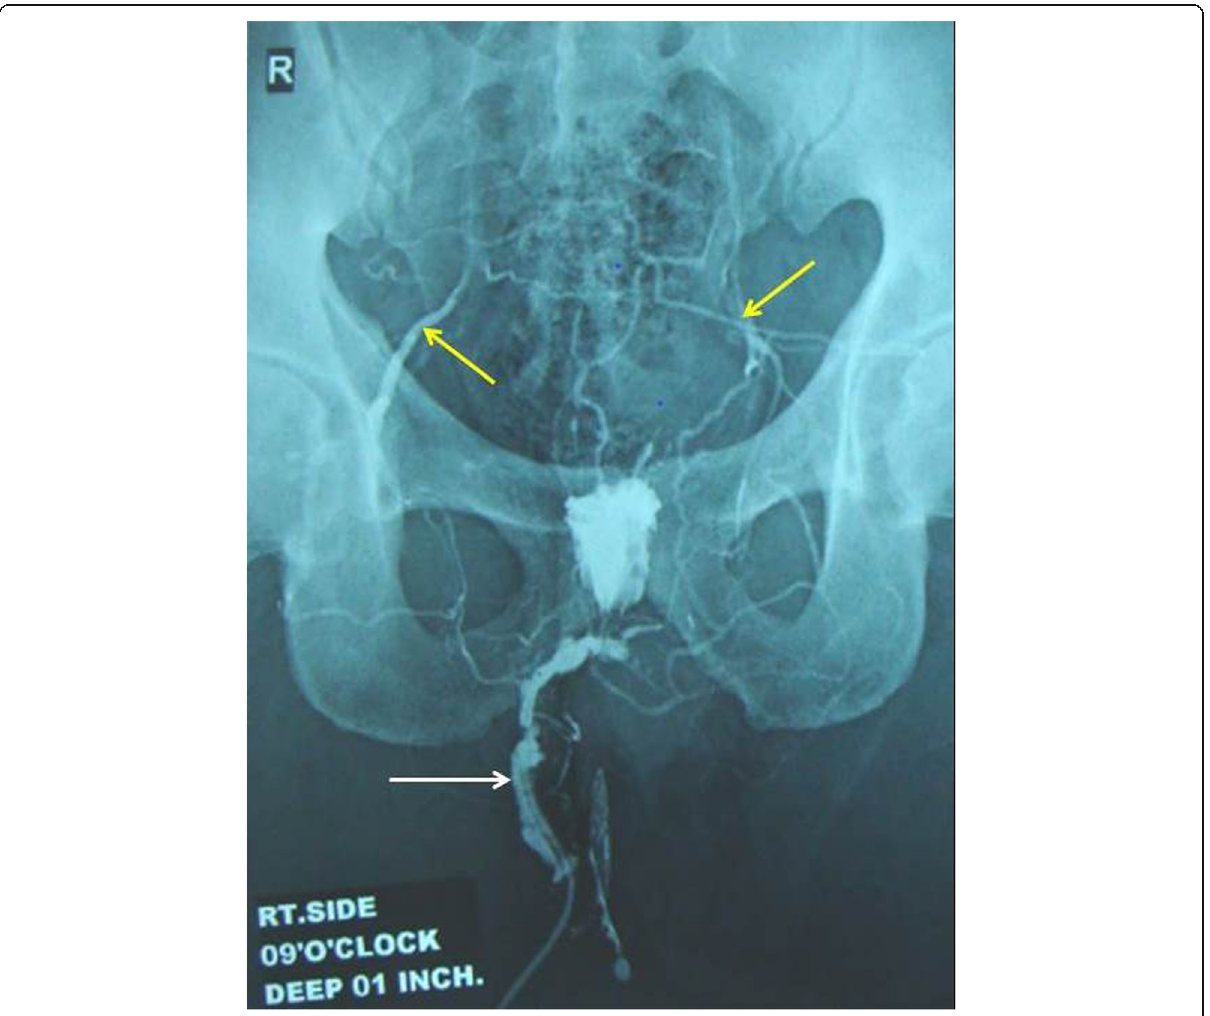
Fig. 3 X-ray pelvis with fistulogram (AP view) showing contrast material in the portal venous circulation (yellow arrows) due to forceful injection of contrast material into the fistulous track (white